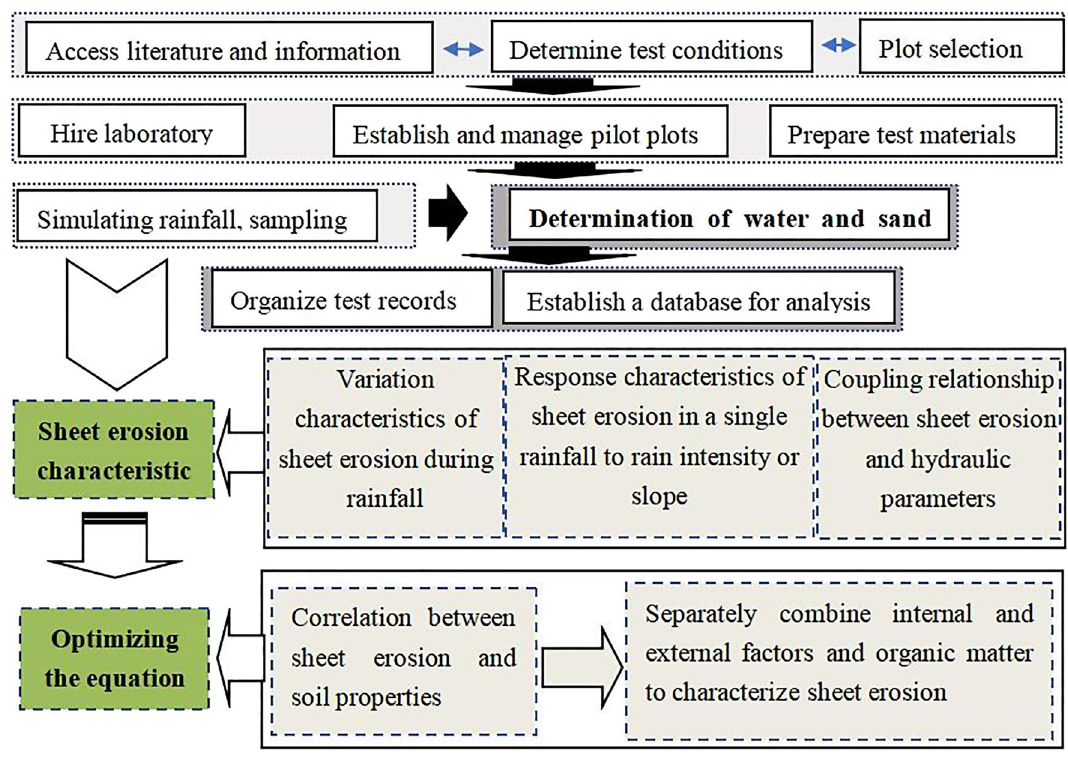
Figure 2. The schematic of the